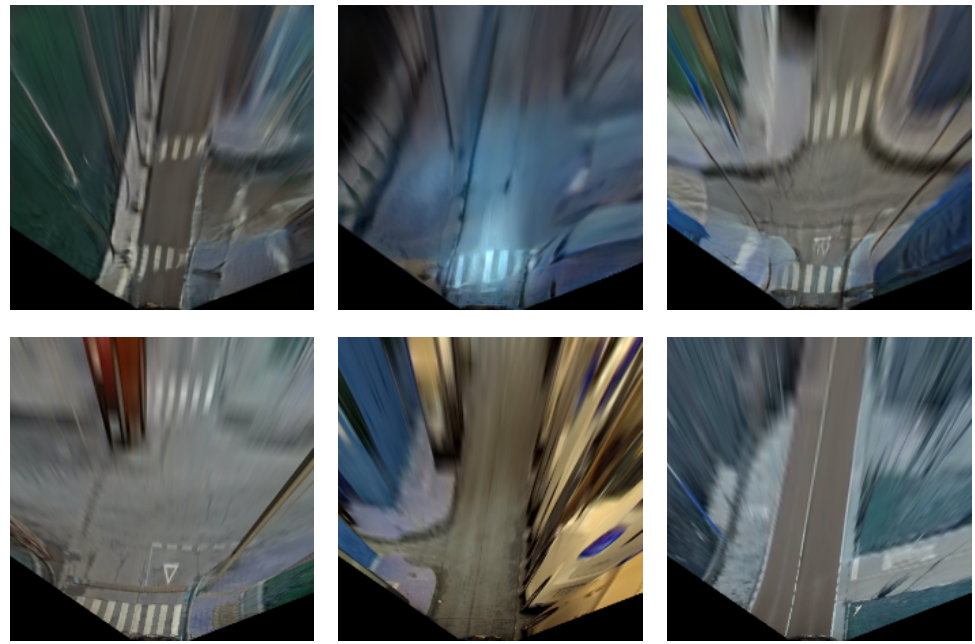
Figure 15. In the first row: some examples of generated images when training the GAN with warped real images. In the second row: examples of real warped